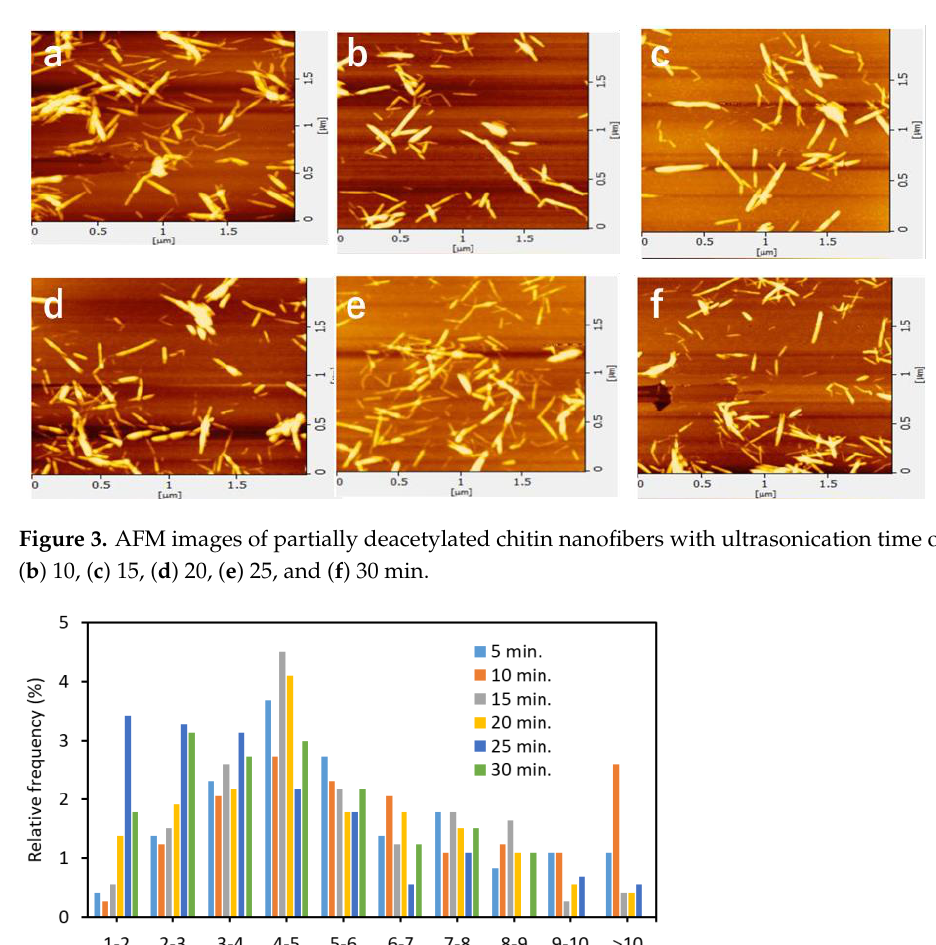
Figure 2. FE-SEM images of partially deacetylated chitin nanofibers with ultrasonication time of ( a ) 5, ( b ) 10, ( c ) 15, ( d ) 20, ( e ) 25, and ( f ) 30 min.